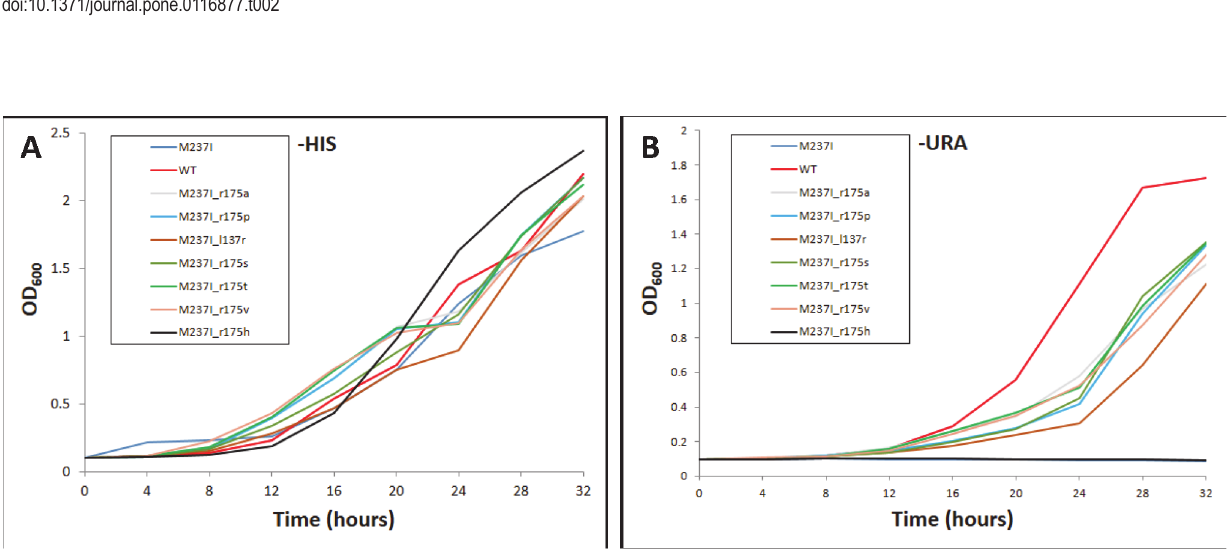
Fig 4. Growth curve analysis of yRB239 yeast expressing p53 wild-type, M237I cancer and rescue mutants, (A) non selective (-HIS), (B) selective (-URA) liquid medium. Absorbance by optical density analysis at 600 nm was assessed over a 32-hour time course by plate reader. Measurements represent the average of two